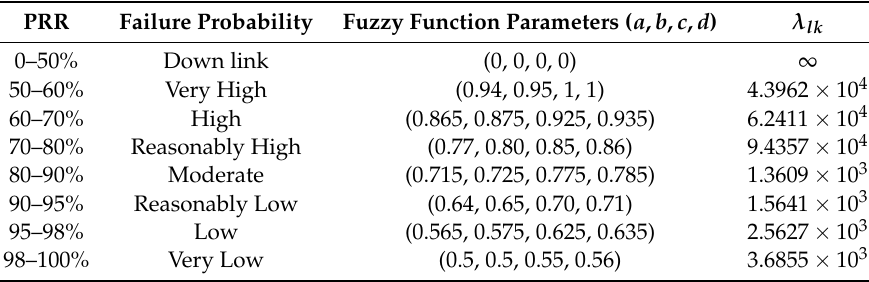
Table 2. Parameters of link reliability and fuzzy model